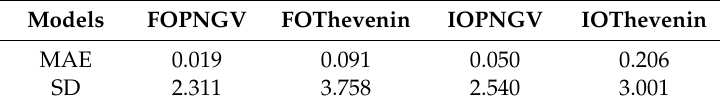
Table 2. Terminal output errors under dynamic conditions (Unit: